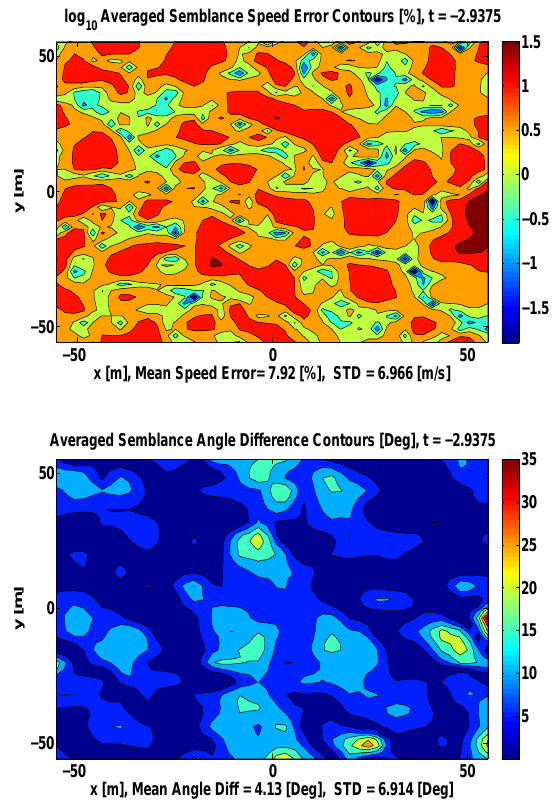
Figure 5. Associated magnitude and direction error analysis for Figure 3 data. Upper color bar units are log are